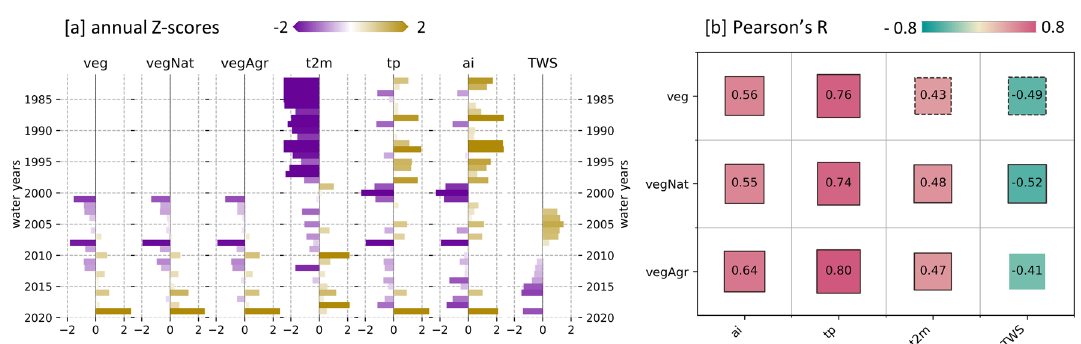
Figure 6. Iran-wide aggregated statistics of vegetation and hydrometeorology. ( a ): Annual Z-scores. Reference period to generate Z-scores applies for all parameters to the common data availability (i.e. period of GRACE TWS ) ( b ): Pearson’s R values with indication of significance of the correlation (solid boundary: p <0.05, dashed boundary: p <0.1, no boundary: p